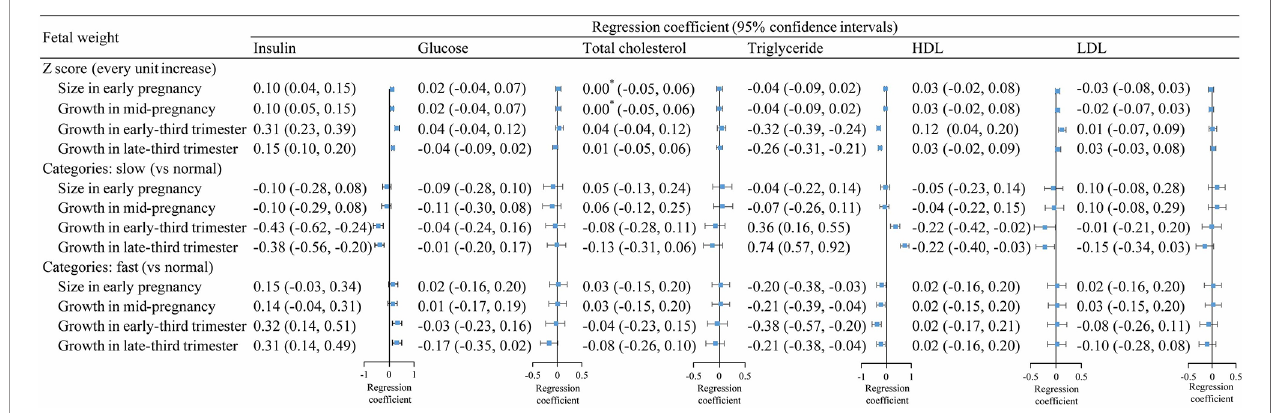
FIGURE 1 | Associations between fetal weight growth in different periods and cord blood metabolic factors. *, >0 and